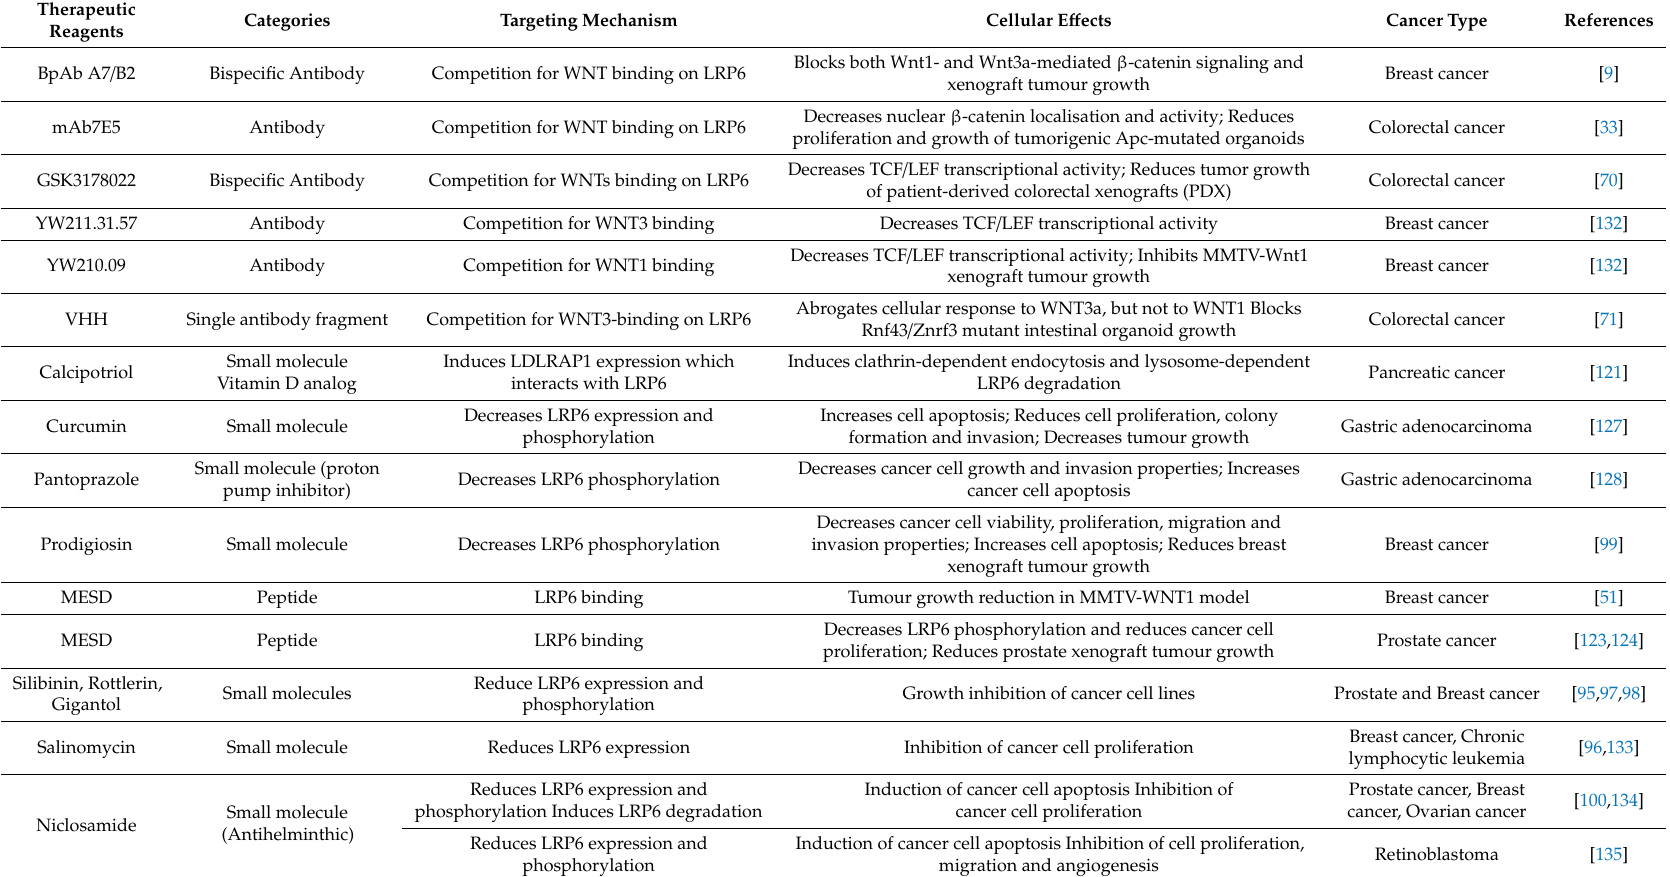
Table 2. List of therapeutic reagents targeting LRP6 in various cancers. Di ff erent antibodies, small molecules and peptides have been shown to exert anticancer properties by directly or indirectly inhibiting LRP6